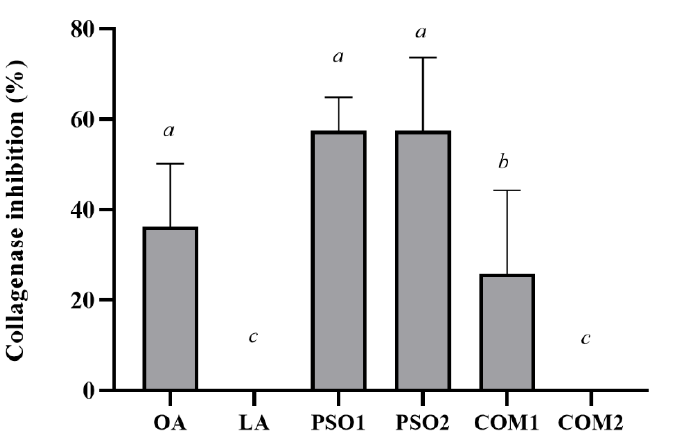
Figure 6. Collagenase inhibitory effect of pumpkin seed oil samples (PSO1, PSO2, COM1, COM2), linoleic acid (LA), and oleanolic acid (OA). Data obtained from triplicate and three independent experiments are expressed as mean ± SD. The letters a , b and c presented significant differences among samples in each experiment, p < 0.05.